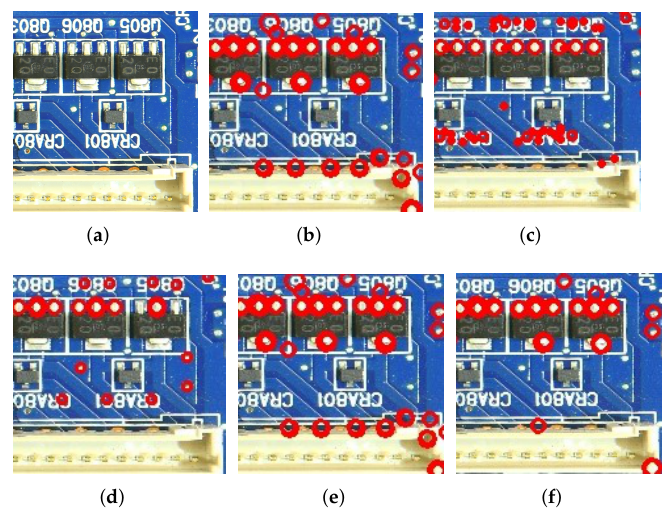
Figure 7. Determinant of Hessian–Blobs feature images with different label mask k-size. ( a ) Original image patch, and ( b – f ) respective experimental results from 25 to 5 image mask size.These six images are different